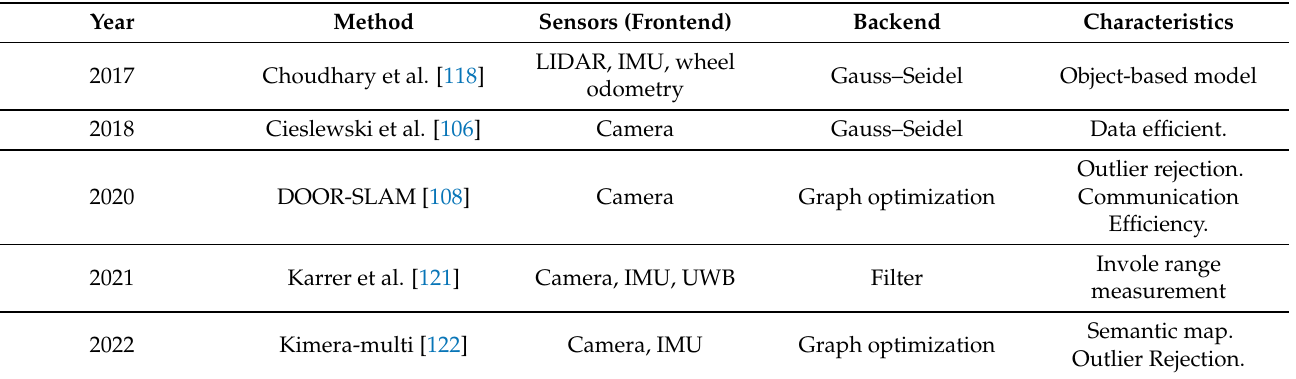
Table 4. Comparison of several distributed SLAM